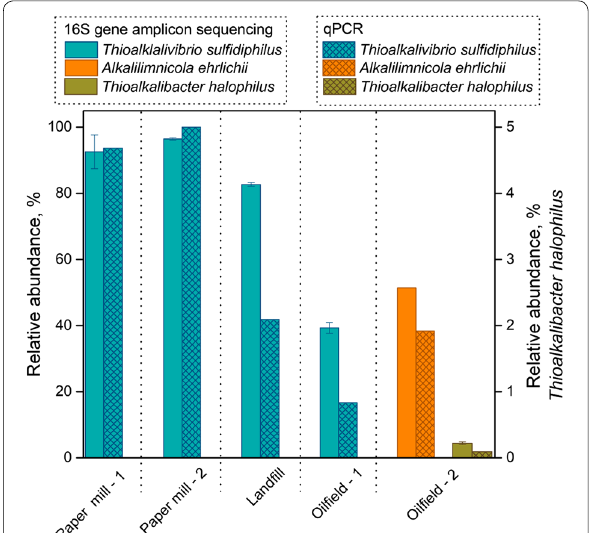
Fig. 2 Comparison of relative taxon abundances using 16S rRNA gene amplicon sequencing (NGS) and species‑specific qPCR from five full‑scale gas biodesulfurization installations. The results represent the average value per full‑scale biodesulfurization installation for each of the target species that was positively detected. Error bars represents the standard deviation of technical duplicates. Amplicon sequence data are modified from Kiragosyan et al.